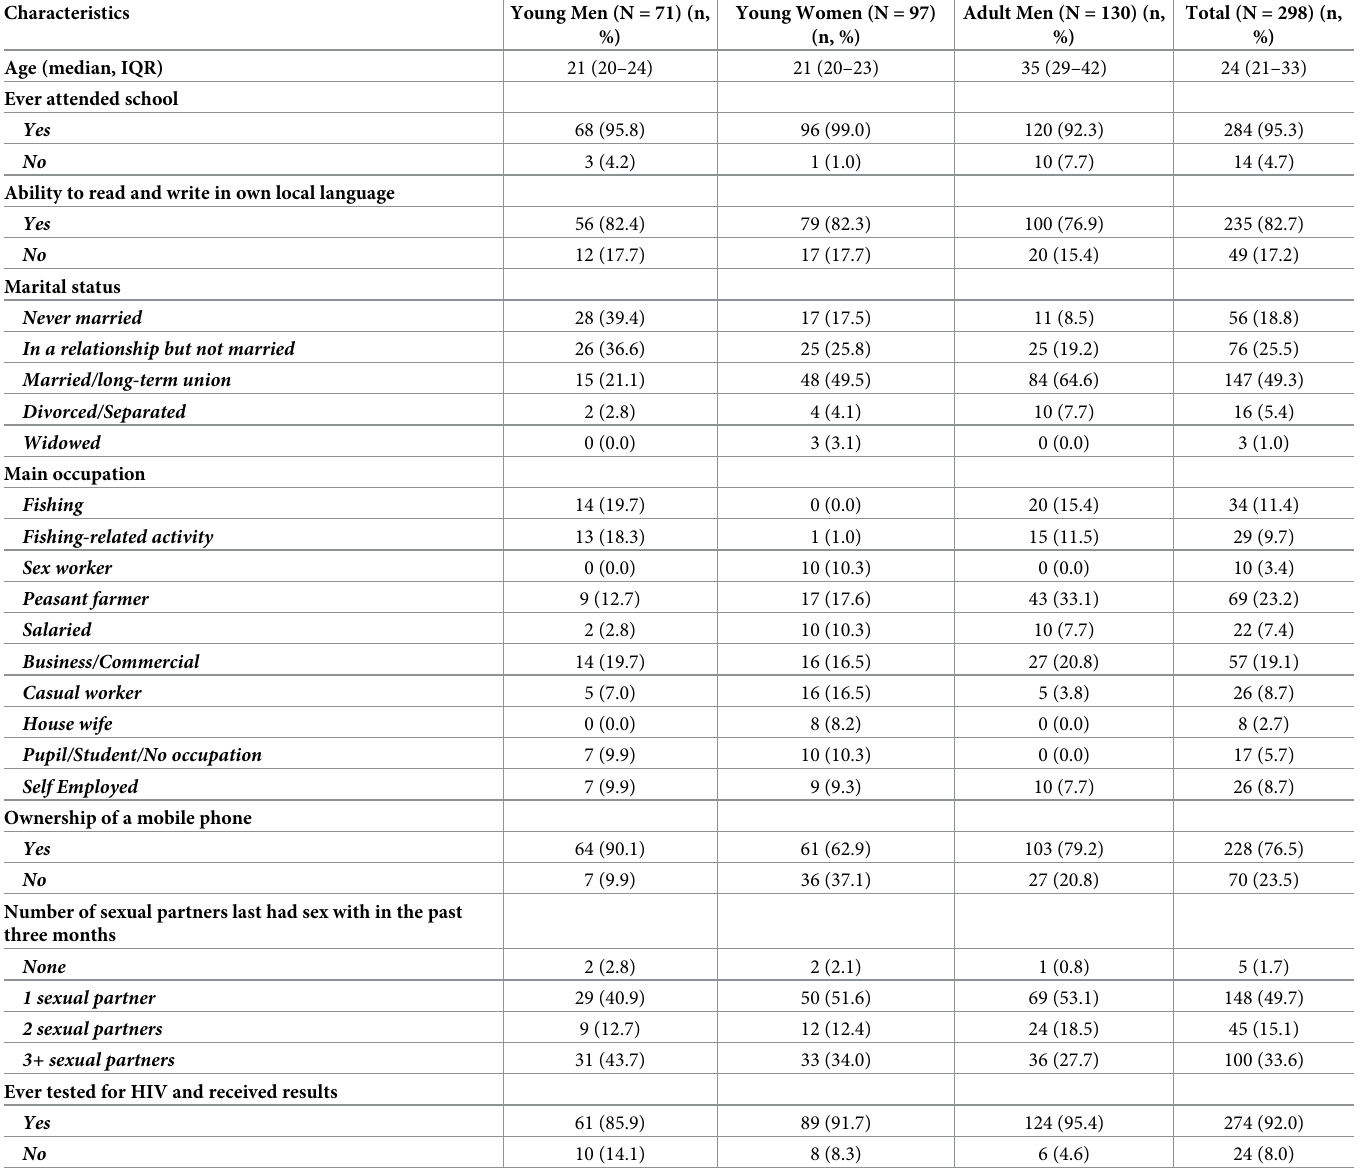
Table 2. Socio-demographic and behavioural characteristics of respondents at